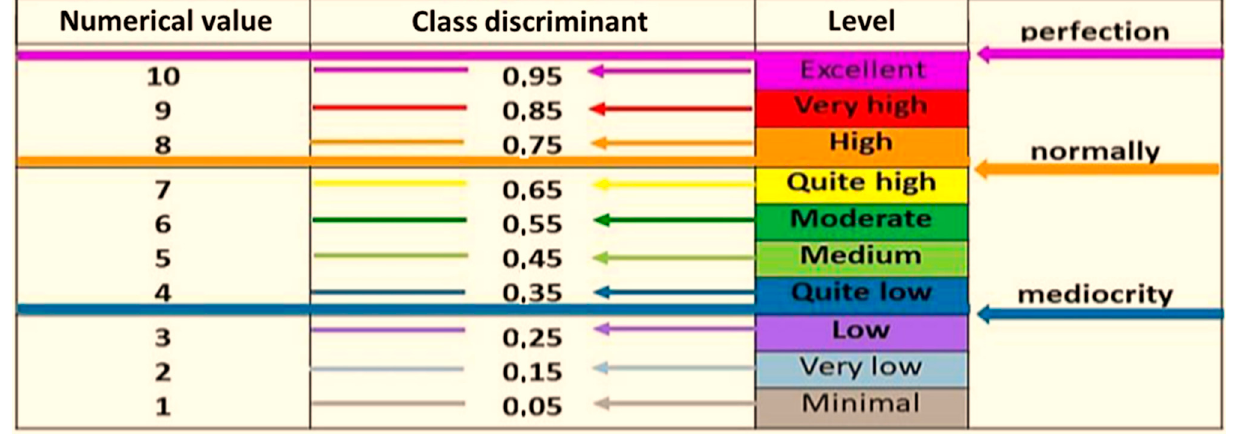
Figure 12. Universal scale of relative states.